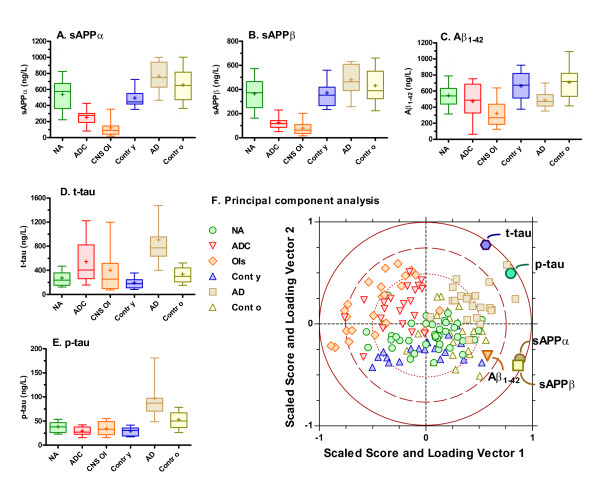
Amyloid and tau CSF biomarker concentrations in the different patient groups and their interactions. Panels A-E plot concentrations of different markers for the 6 subject groups. Boxes encompass interquartile ranges with median (line) and mean ("+"), while whiskers designate 10th to 90th percentiles. Results of statistical analysis of these data are given in Table 2A. Panel F shows the principal component analysis (PCA) score scatter plot of subjects identified by disease grouping with the superimposed variable loadings of the biomarkers. The data in Panels A - E were used to construct a two-dimensional model along the two vectors. The individual subjects are represented by the small symbols as indicated in the key, and their placement is determined by the combination of their marker values in the model. The placement of the five variables (large symbols as indicated) gives information about how each affects the placement of the individuals in the plot, both with respect to direction along each vector axis and the relative magnitude of this effect as indicated by their distance from the origin. For example, high p-tau and low sAPPβ values contribute importantly to the position in the upper right and left quadrants, respectively. Note, however, that all variables influence where each subject is located in the plot so that the plot provides a visual representation of how the subjects are separated by the results of all five biomarkers. For more detailed information on methods, see reference [35]. Abbreviations: NA, HIV+ neuroasymptomatics; ADC, AIDS dementia complex; CNS OIs, CNS opportunistic infections; Contr y, younger HIV- controls; AD, Alzheimer's disease; Contr o, older HIV- controls.